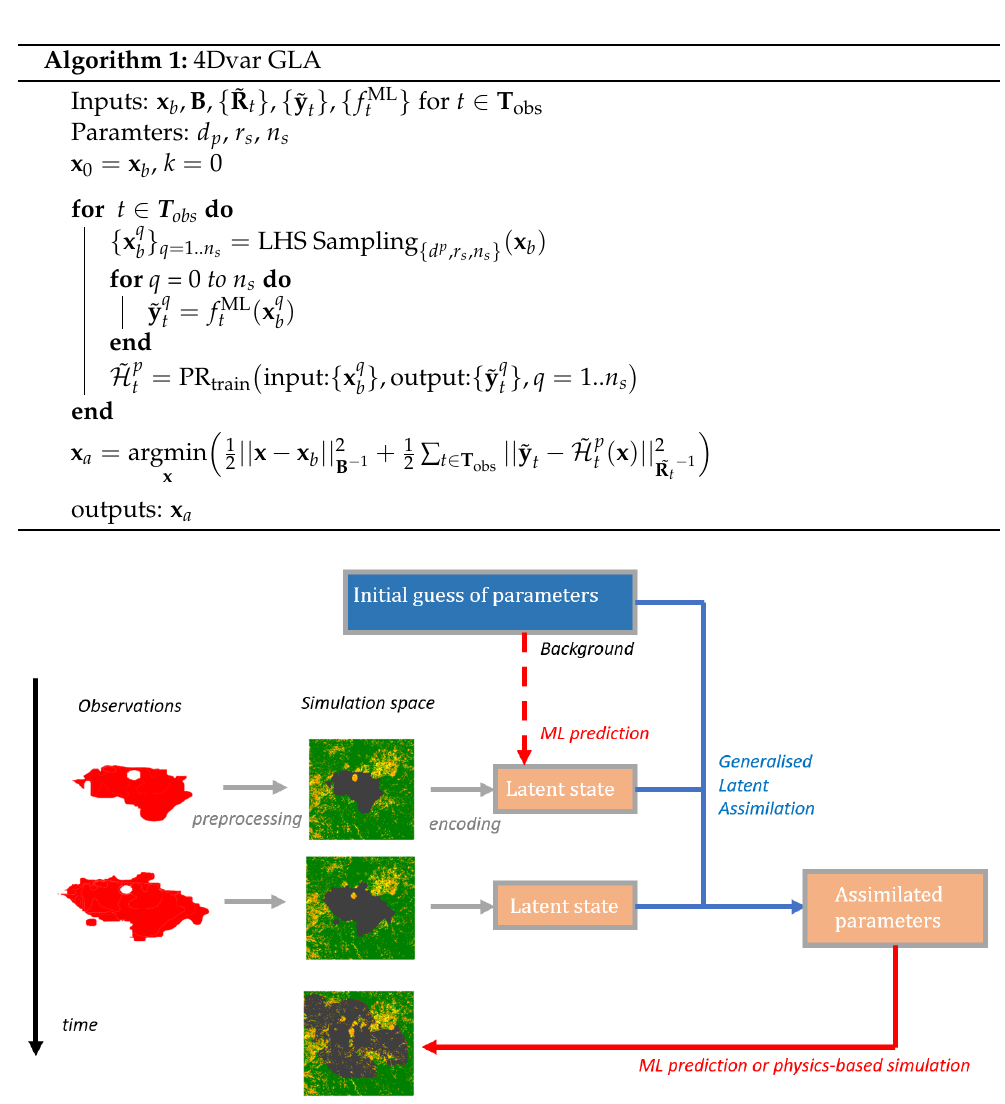
Figure 3. Flowchart of the inverse model for parameter identification using